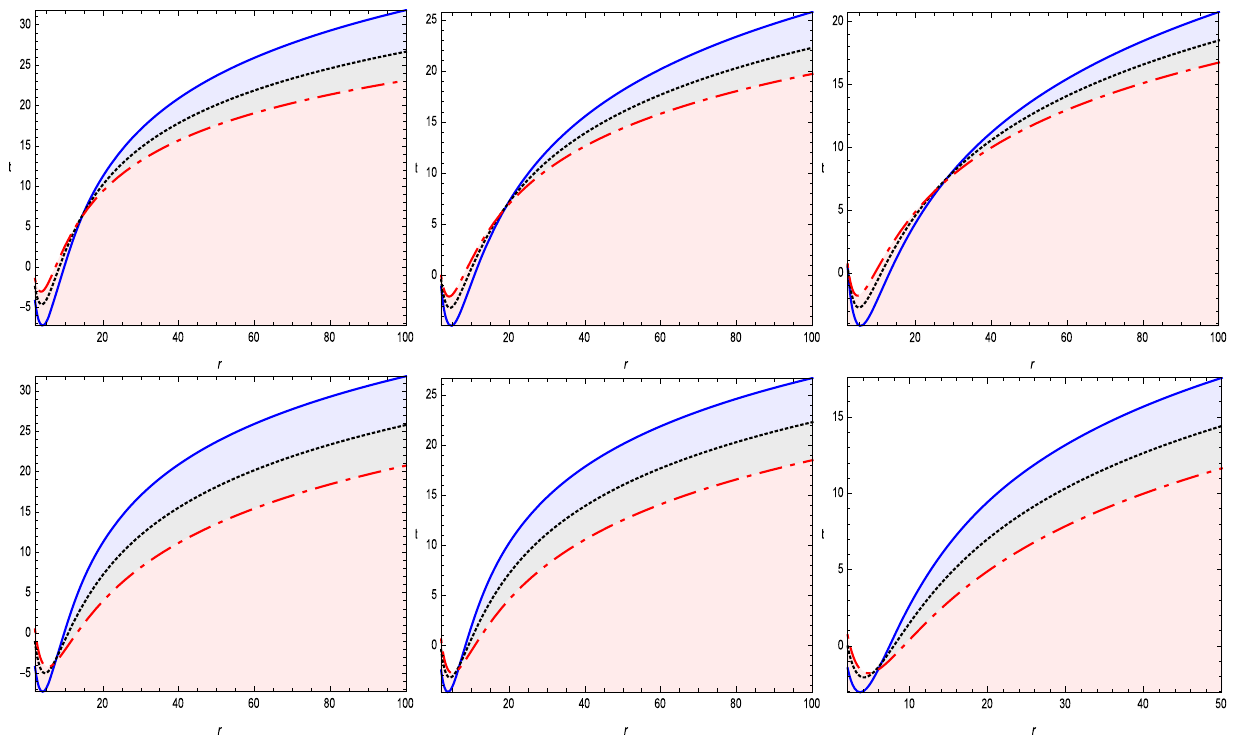
panel of the second row represents a = 0 . 7 (blue), a = 0 . 8 (black), and a = 0 . 9 (red) with q = 0 . 05. The middle panel of the second row represents a = 0 . 7 (blue), a = 0 . 8 (black), and a = 0 . 9 (red) with q = 0 . 06. The right panel of the second row represents a = 0 . 7 (blue), a = 0 . 8 (black), and a = 0 . 9 (red) with q = 0 .